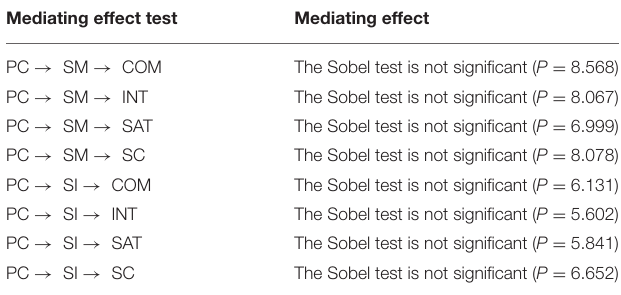
TABLE 6 | Sobel test